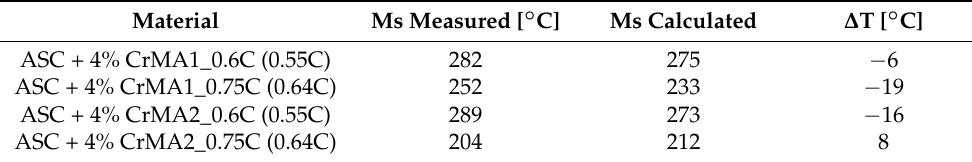
Table 4. Difference between calculated (after [27]) and measured Ms temperature. Material Ms Measured [ ◦